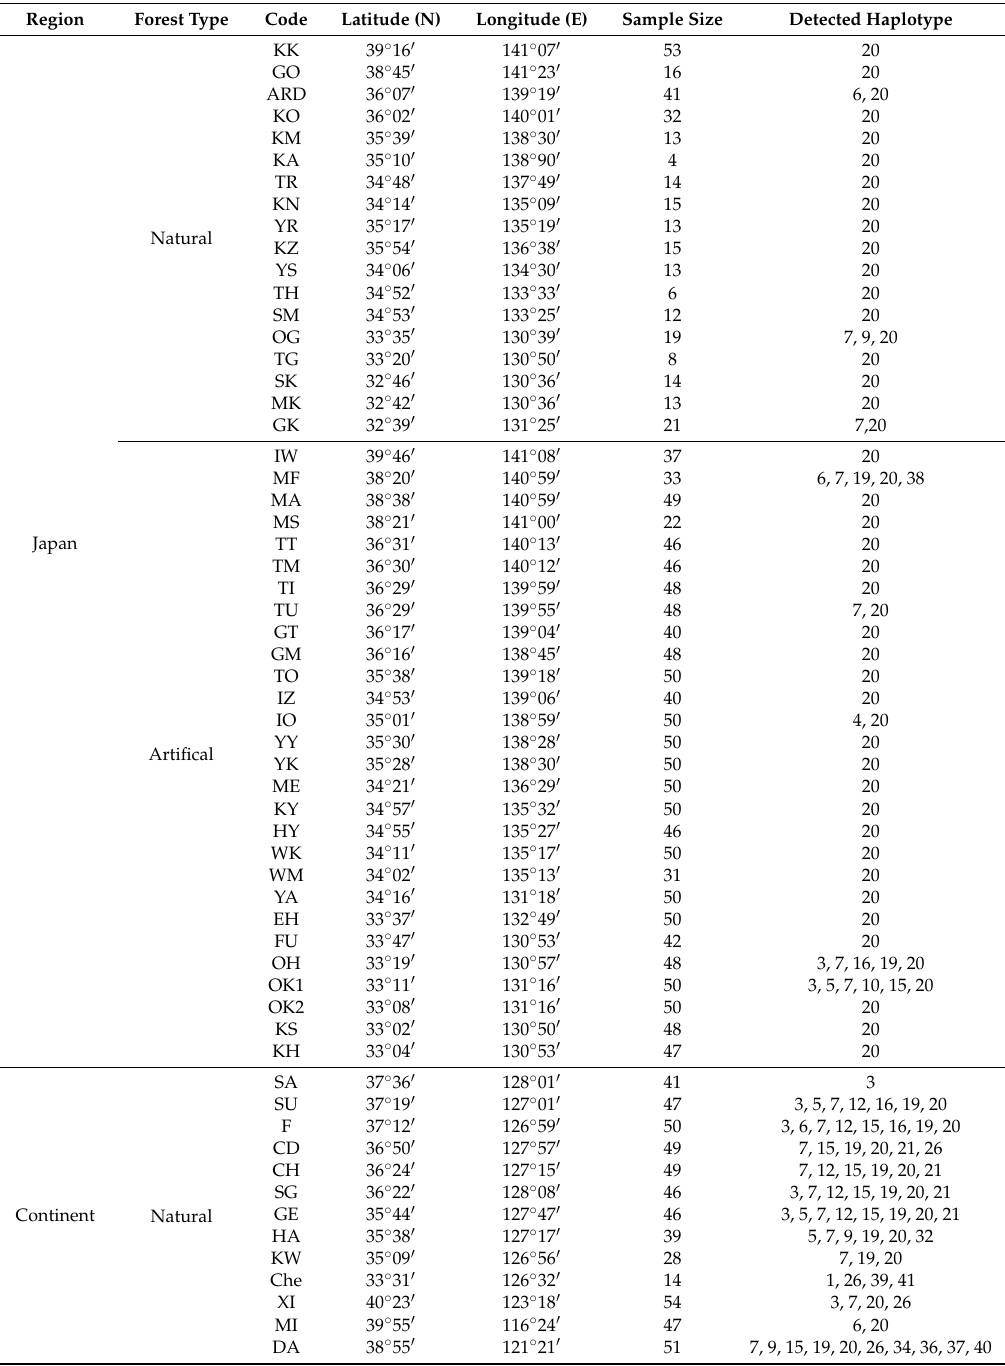
Table 1. Populations and sample size of Quercus acutissima Carruth. forest and detected haplotypes. Region Forest Type Code Latitude (N) Longitude (E) Sample Size Detected Haplotype